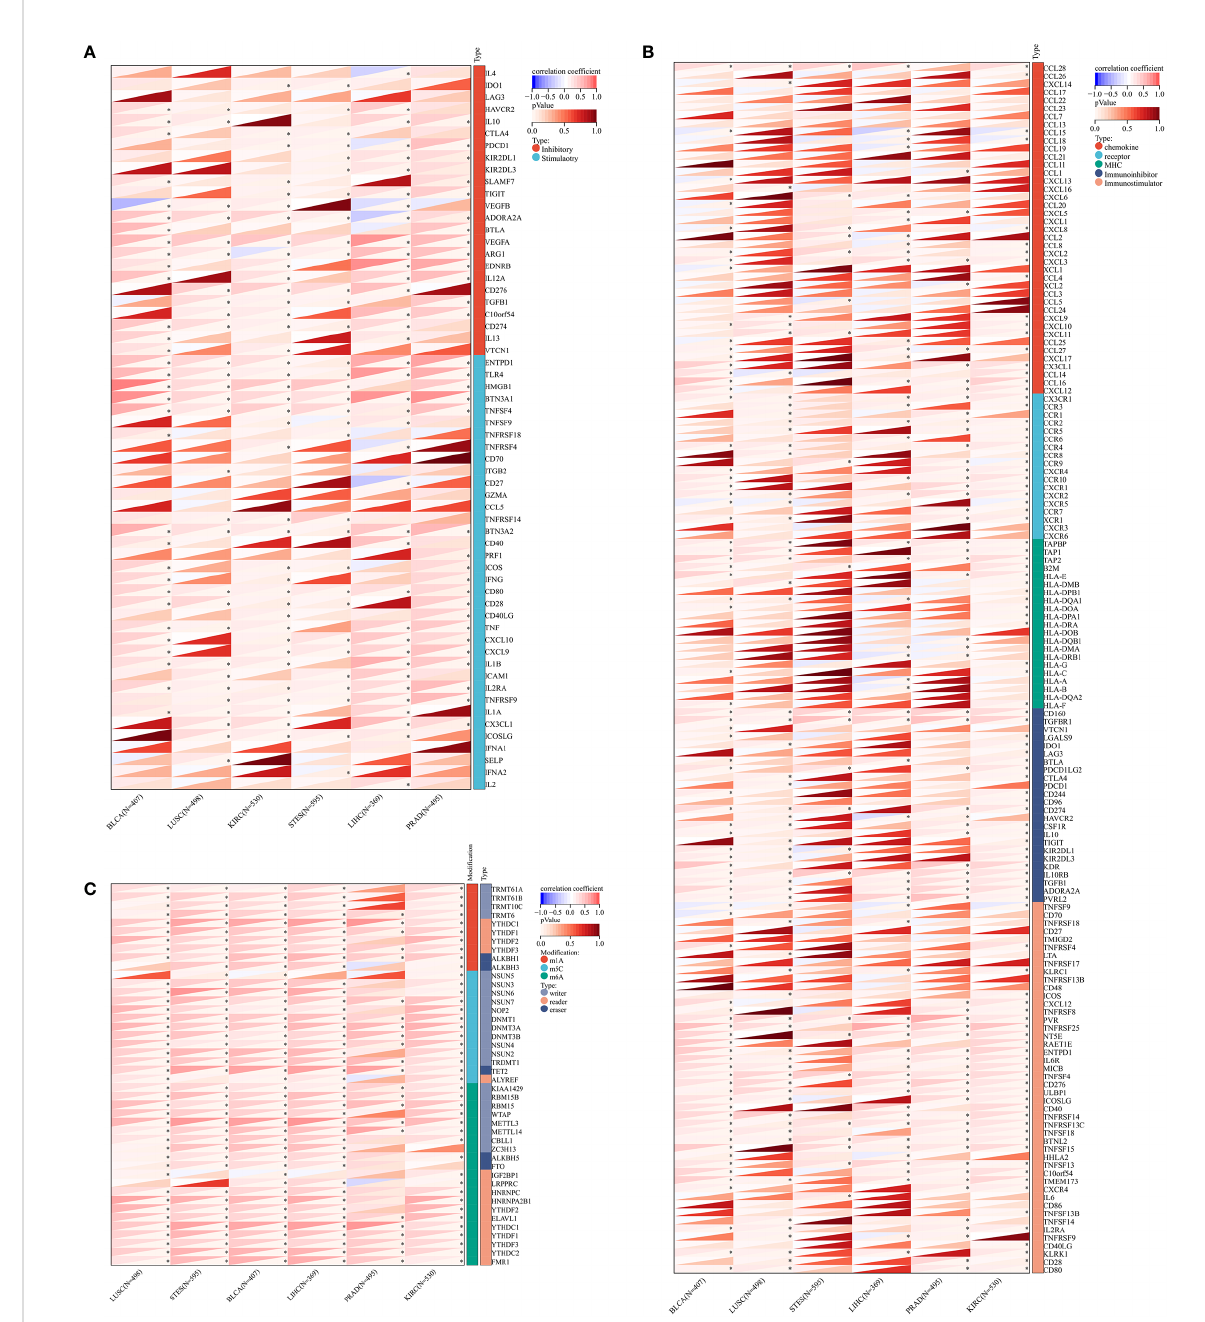
FIGURE 4 The Spearman analysis of ZNF419 expression and genes functioning in immune checkpoints, immune regulation, and RNA modi fi cation. (A) the correlation of ZNF419 expression with genes of immune checkpoints; (B) the correlation of ZNF419 expression with immune regulatory genes; (C) the correlation of ZNF419 expression with genes of RNA modi fi cation. *The p value was less than